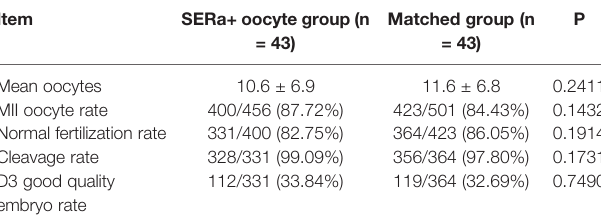
TABLE 3 | Embryological outcomes of SERa+* oocyte group and the matched group. Item